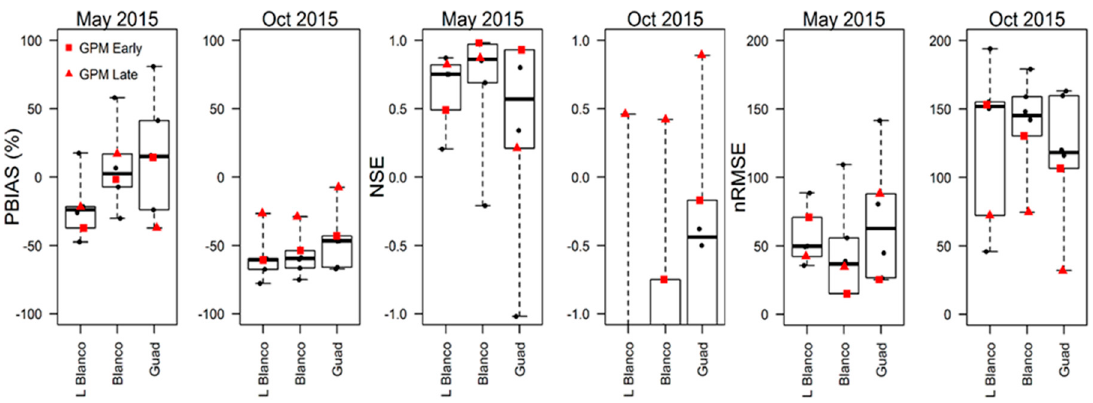
Figure 5. Performance statistic results for the non-gauge adjusted satellite results for the May and October 2015 storms that included the GPM products.